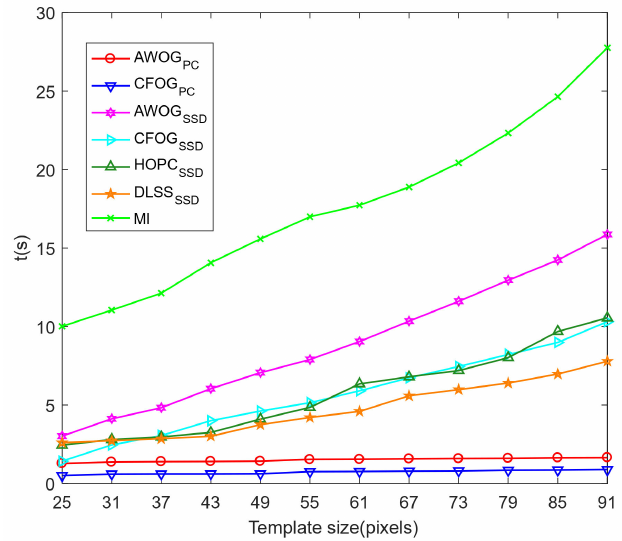
Figure 12. The average running times of all methods under different sizes of template